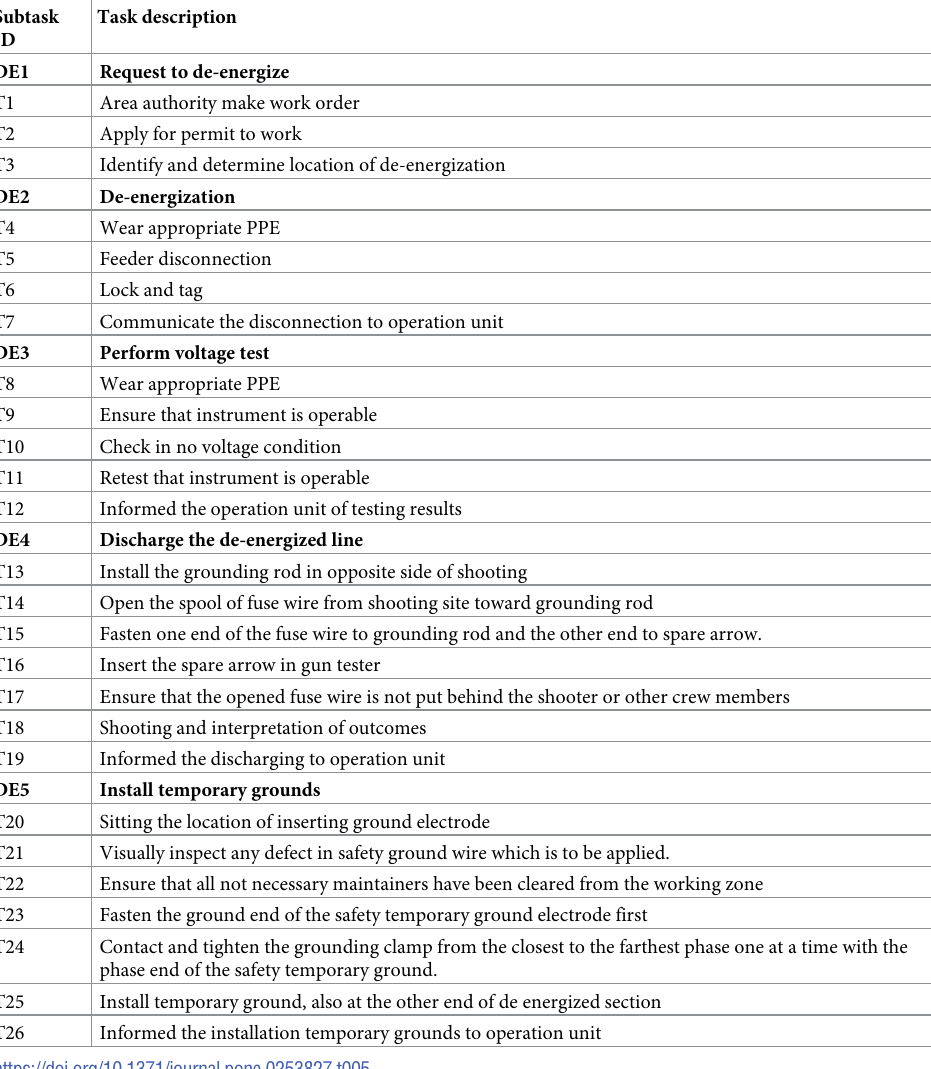
Table 5. Hierarchical task analysis for the de energization power